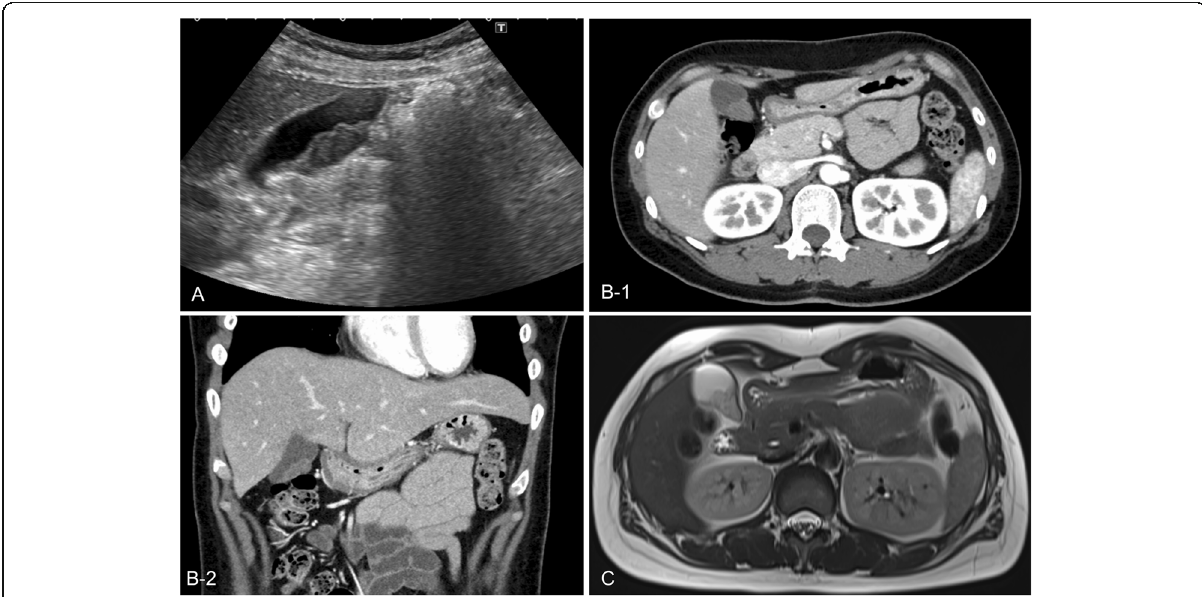
Fig. 1 a US image showing a mass in the gallbladder. b-1 CECT scan image showing a mass in the gallbladder wall that takes up contrast. b-2 CECT scan image showing a mass in the gallbladder wall that takes up contrast. c MRI T2 image showing a gallbladder lesion with